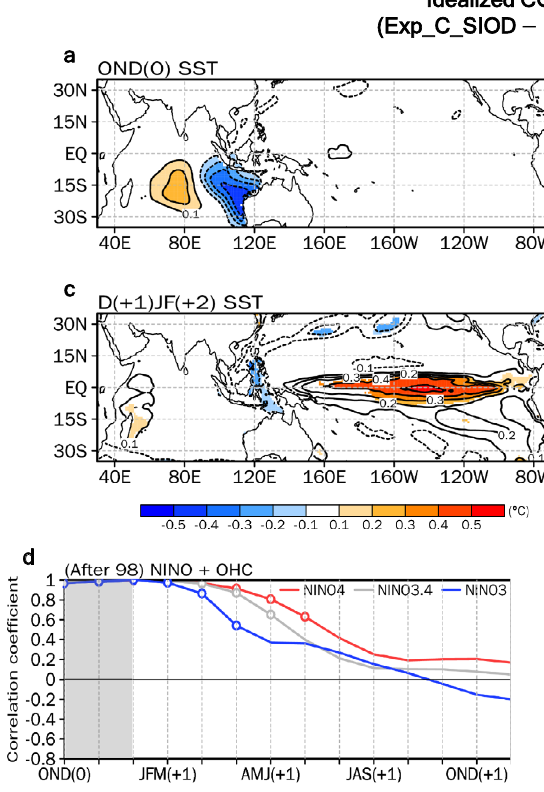
Niño4 SST (red), Niño3.4 SST (grey), and Niño3 SST (blue) indices from the OND season to the subsequent year ’ s boreal early winter (NDJ) season using a combi- nationoftheborealwinter(DJF)NiñoandtheDJFoceanheatcontent(OHC)indices for1998 – 2019. f Asin e , but using the OND SIOD index.The grey box indicates the developing seasons of the SIOD. The open circles in d , and e indicate correlation coef fi cientsthatarestatisticallysigni fi cantatthe95%con fi dencelevel.Aleave-one- year-out cross-validation method is